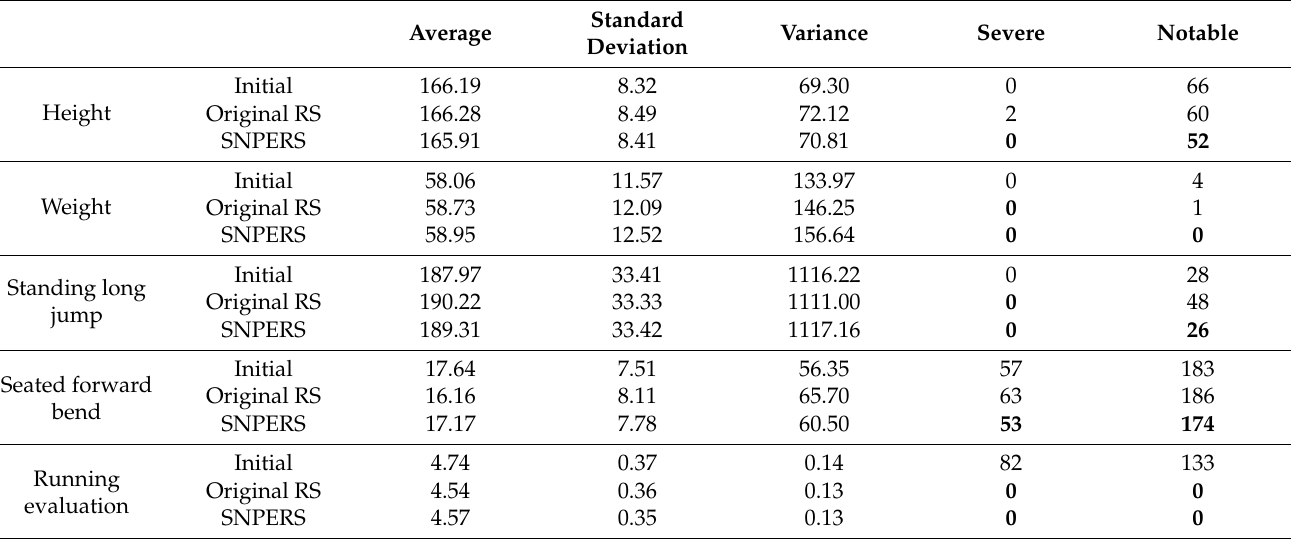
Table 4. The comparison between the original physique and the students’ physique after training according to different recommended programs. Severe or abnormally significant numbers are counted separately, and it can be seen that among students who use SNPERS for physical fitness training, there are fewer cases of severe poor physical